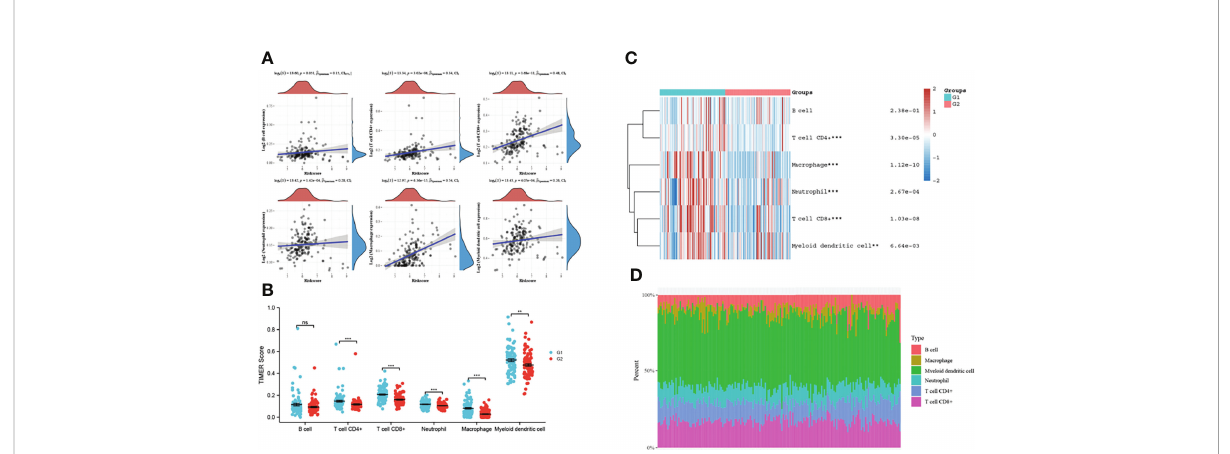
FIGURE 9 VAMP2 and immune correlation. (A) : relationship between VAMP2 and TIMER immune in fi ltrating cells; (B) : the relationship between VAMP2 and each immune cell score; (C) : heat map of immune cell scores; (D) : percentage abundance of tumor-in fi ltrating immune cells in each sample. **p<0.01, ***p<0.001 compared with the two groups. ns, no signi fi